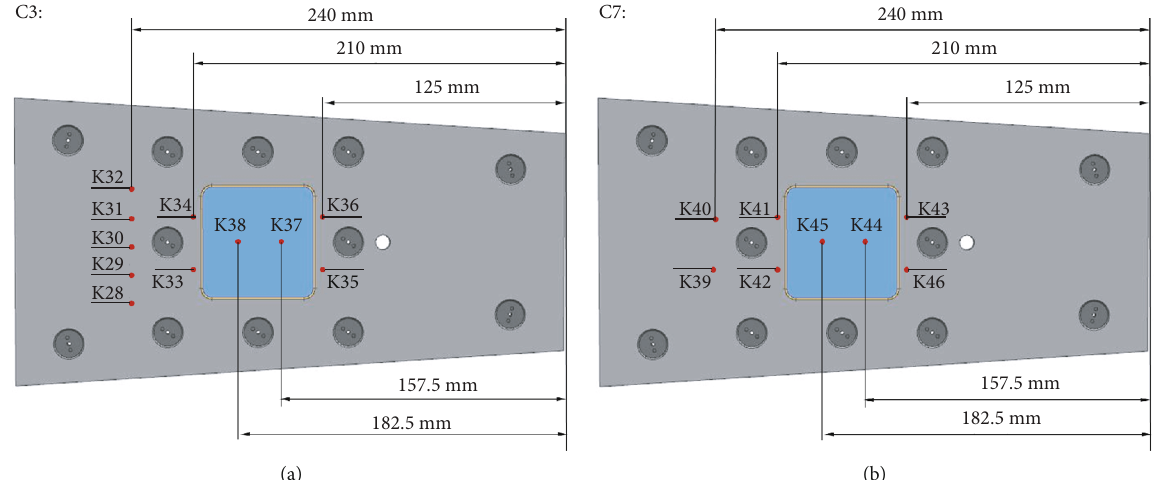
Figure 15: AKTiV thermocouple locations on the experiment (C3) and the reference (C7).